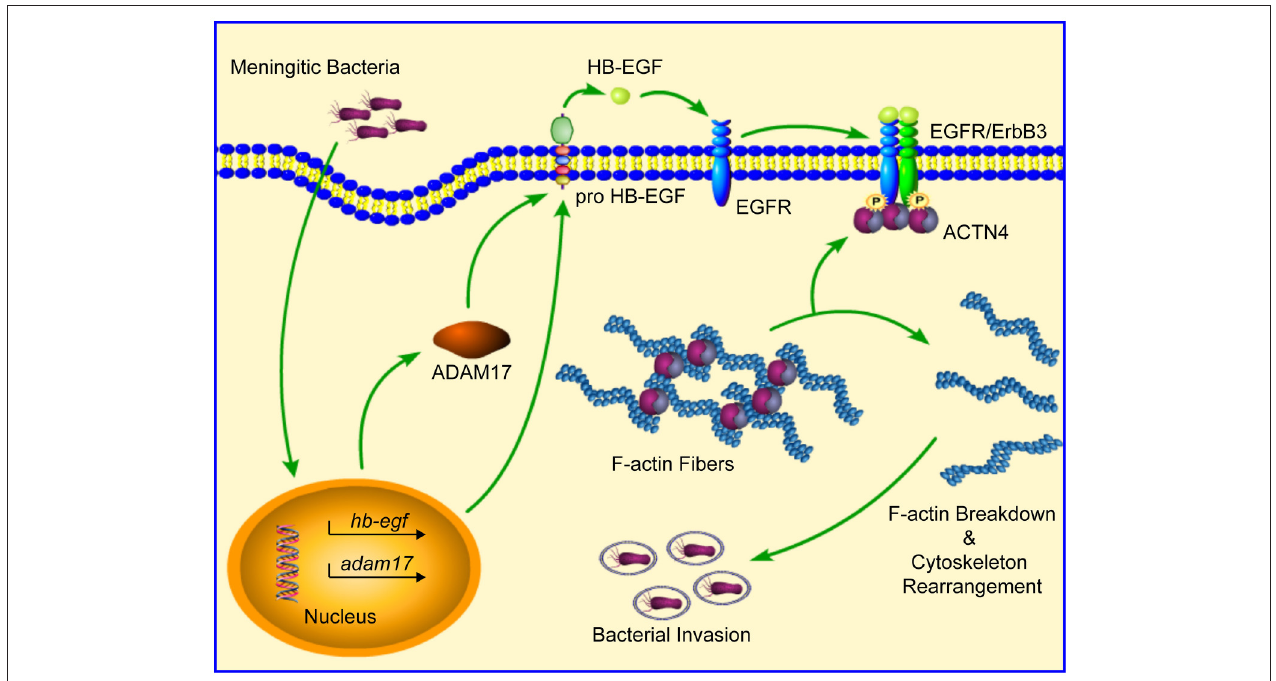
FIGURE 8 | Schematic representation of the mechanism involving EGFR in meningitic bacterial penetration of the BBB. Bacterial infection of hBMECs induces the ligand (HB-EGF)-dependent transactivation of EGFR, which requires the cleavage activity of ADAM17. Activated EGFR dimerizes with its heterogenous partner ErbB3, and then competitively recruits and disassembles ACTN4 from the intracellular F-actin fibers, leading to breakdown as well as reorganization of the actin cytoskeleton, which eventually facilitates bacterial invasion.